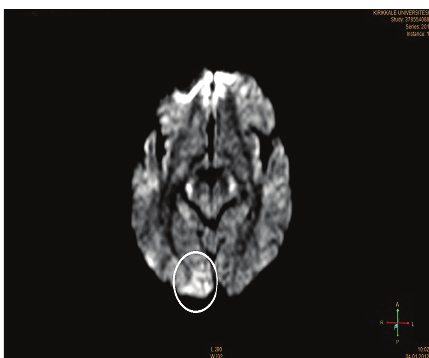
Figure 1: Axial diffusion-weighted echo-planar MR image (appar- ent diffusion coefficient shows an area of restricted diffusion in right occipital lobe). Figure 2: CT scan with contrast enhancement disclosed dissection in the brachiocephalic trunk